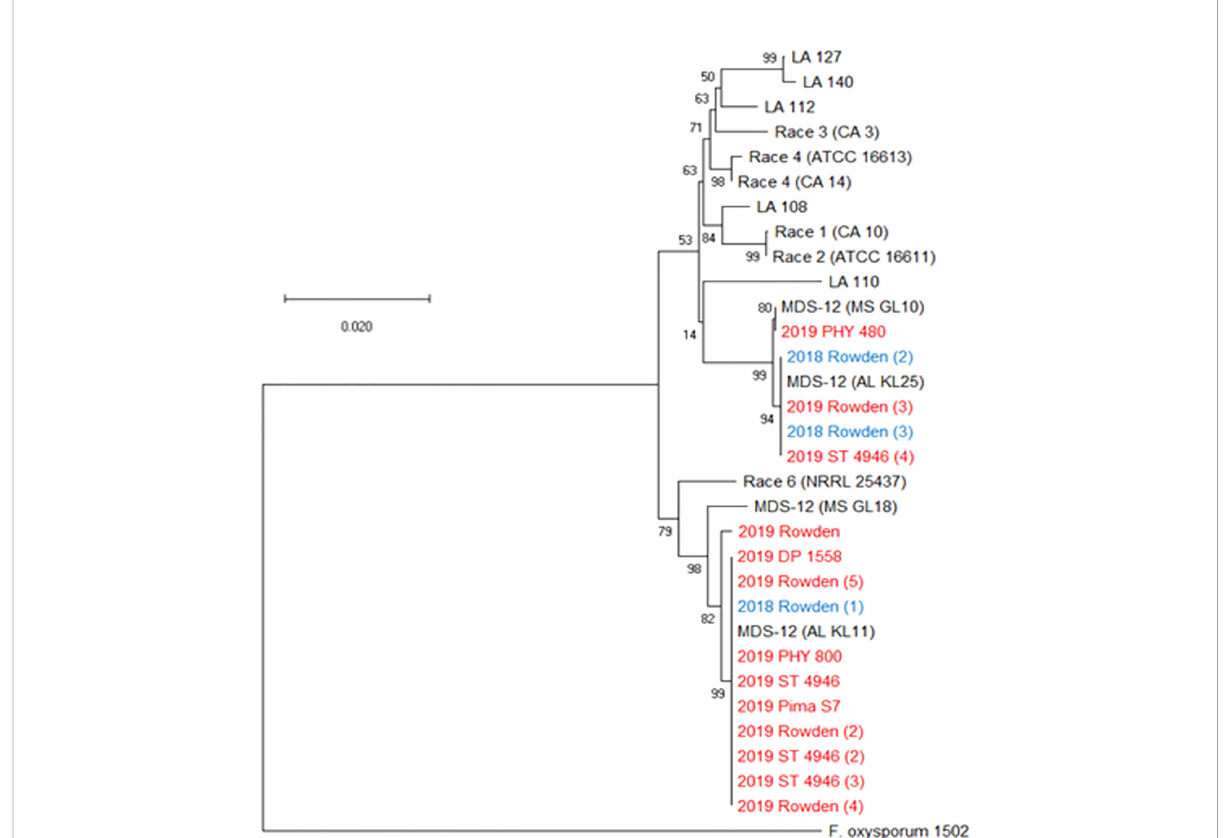
FIGURE 5 Phylogenetic tree of FOV isolates collected during the 2018 and 2019 cotton seasons using a partial sequence analysis of the translation elongation factor and nearly full-length sequences of the intergenic spacer region. This tree only shows isolates that were identi fi ed as FOV race 4 and MDS-12 when sequenced at the translation elongation factor, b -tubulin, and the phosphate permease gene regions, and thus required further sequencing for identi fi cation. Tree was constructed in MEGAX using the maximum likelihood method based on the Tamura-Nei model (Tamura and Nei, 1993). The tree with the highest log likelihood (-7043.88) is shown. Bootstrap frequencies from 1,000 replications are noted next to every branch. Isolates are labeled with the year that they were collected followed by the cultivar from which they were collected, in the case of isolates having the identical name, a number was added in parenthesis to separate isolates. For example, isolate 2018 Rowden (2) represents the second isolate collected from the Rowden cultivar in 2018. Isolates collected during the 2018 season are shown in blue and isolates collected during 2019 are shown in red. Reference isolates (in black) used for comparison are labeled by the race followed by an isolate name, for example Race 1 (CA10) is a race 1 reference isolate identi fi ed as CA 10. A non-pathogenic Fusarium oxysporum (isolate 1502) was used as an outgroup to root the